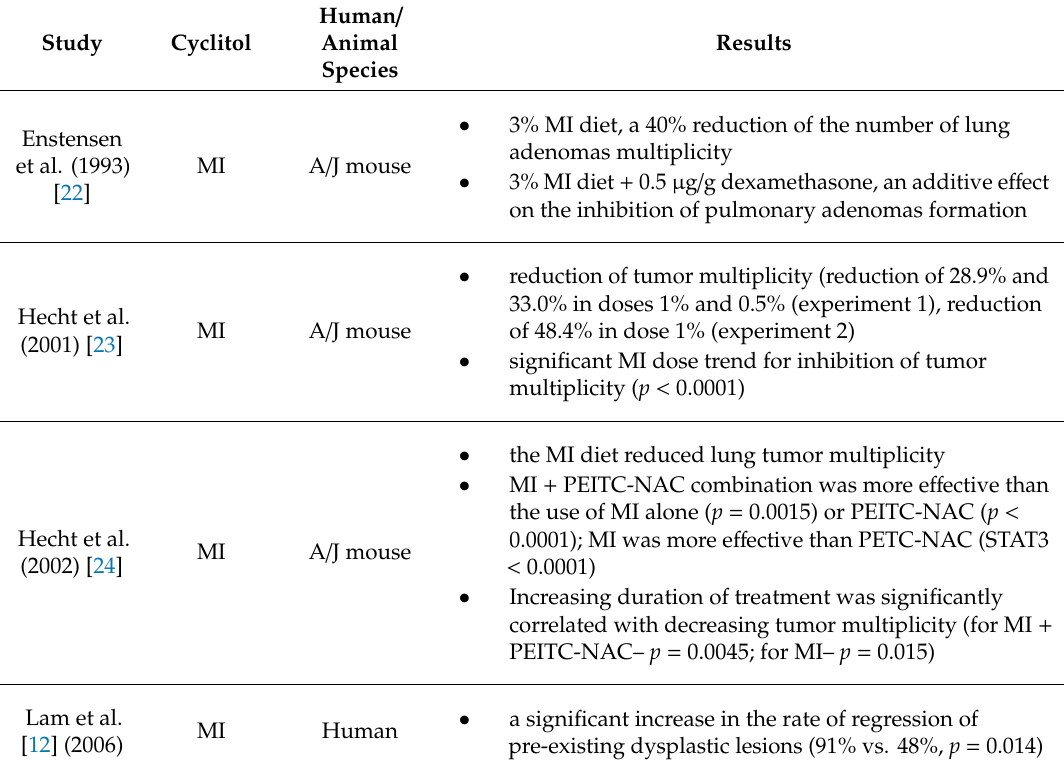
Table 1. Antineoplastic activity of cyclitols in lung / bronchus cancer